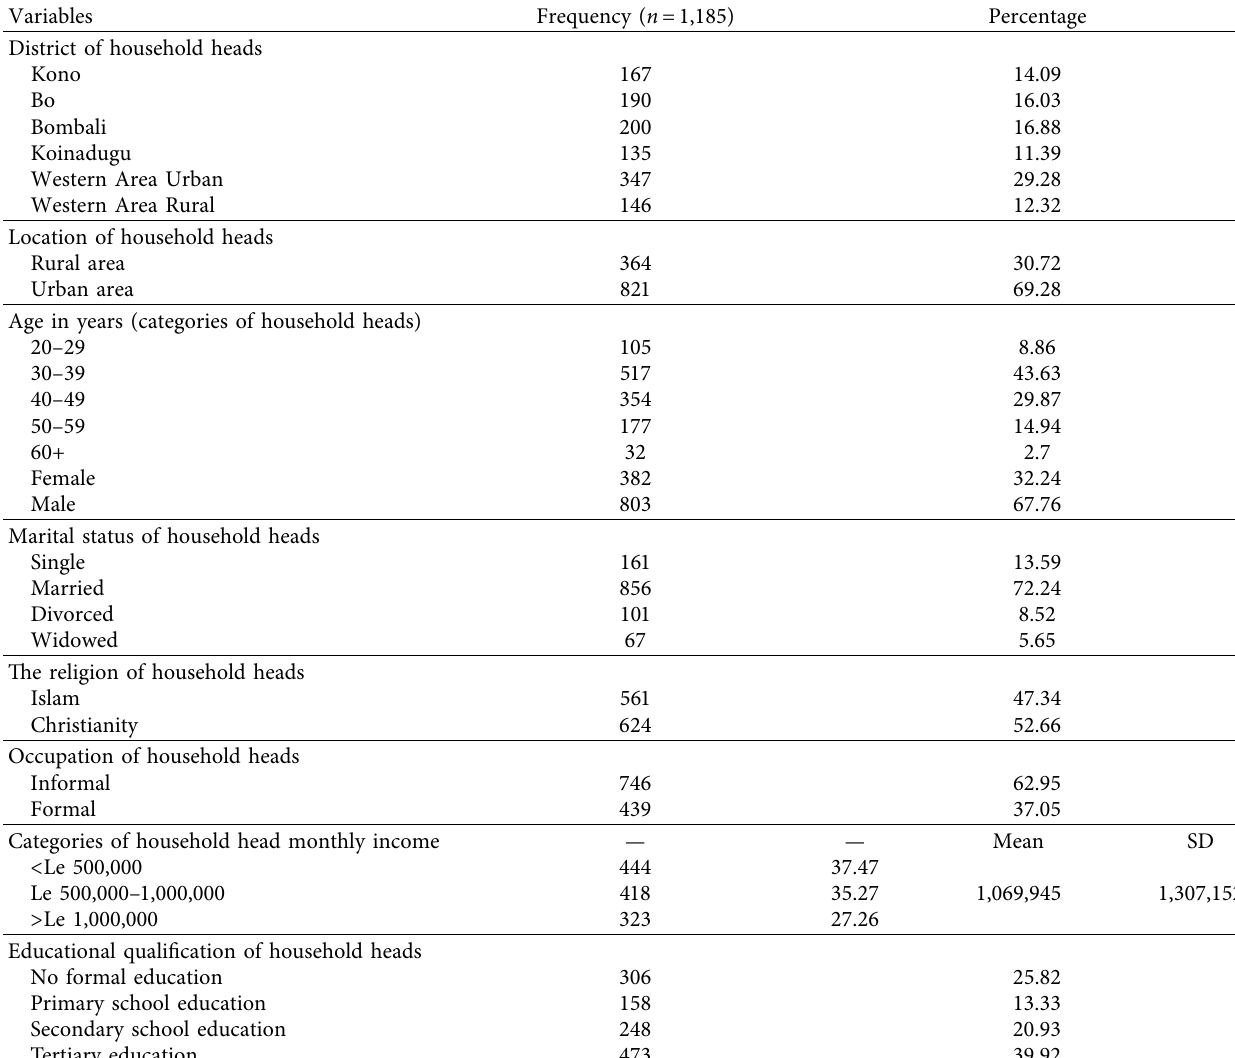
Table 1: Sociodemographic characteristics of household